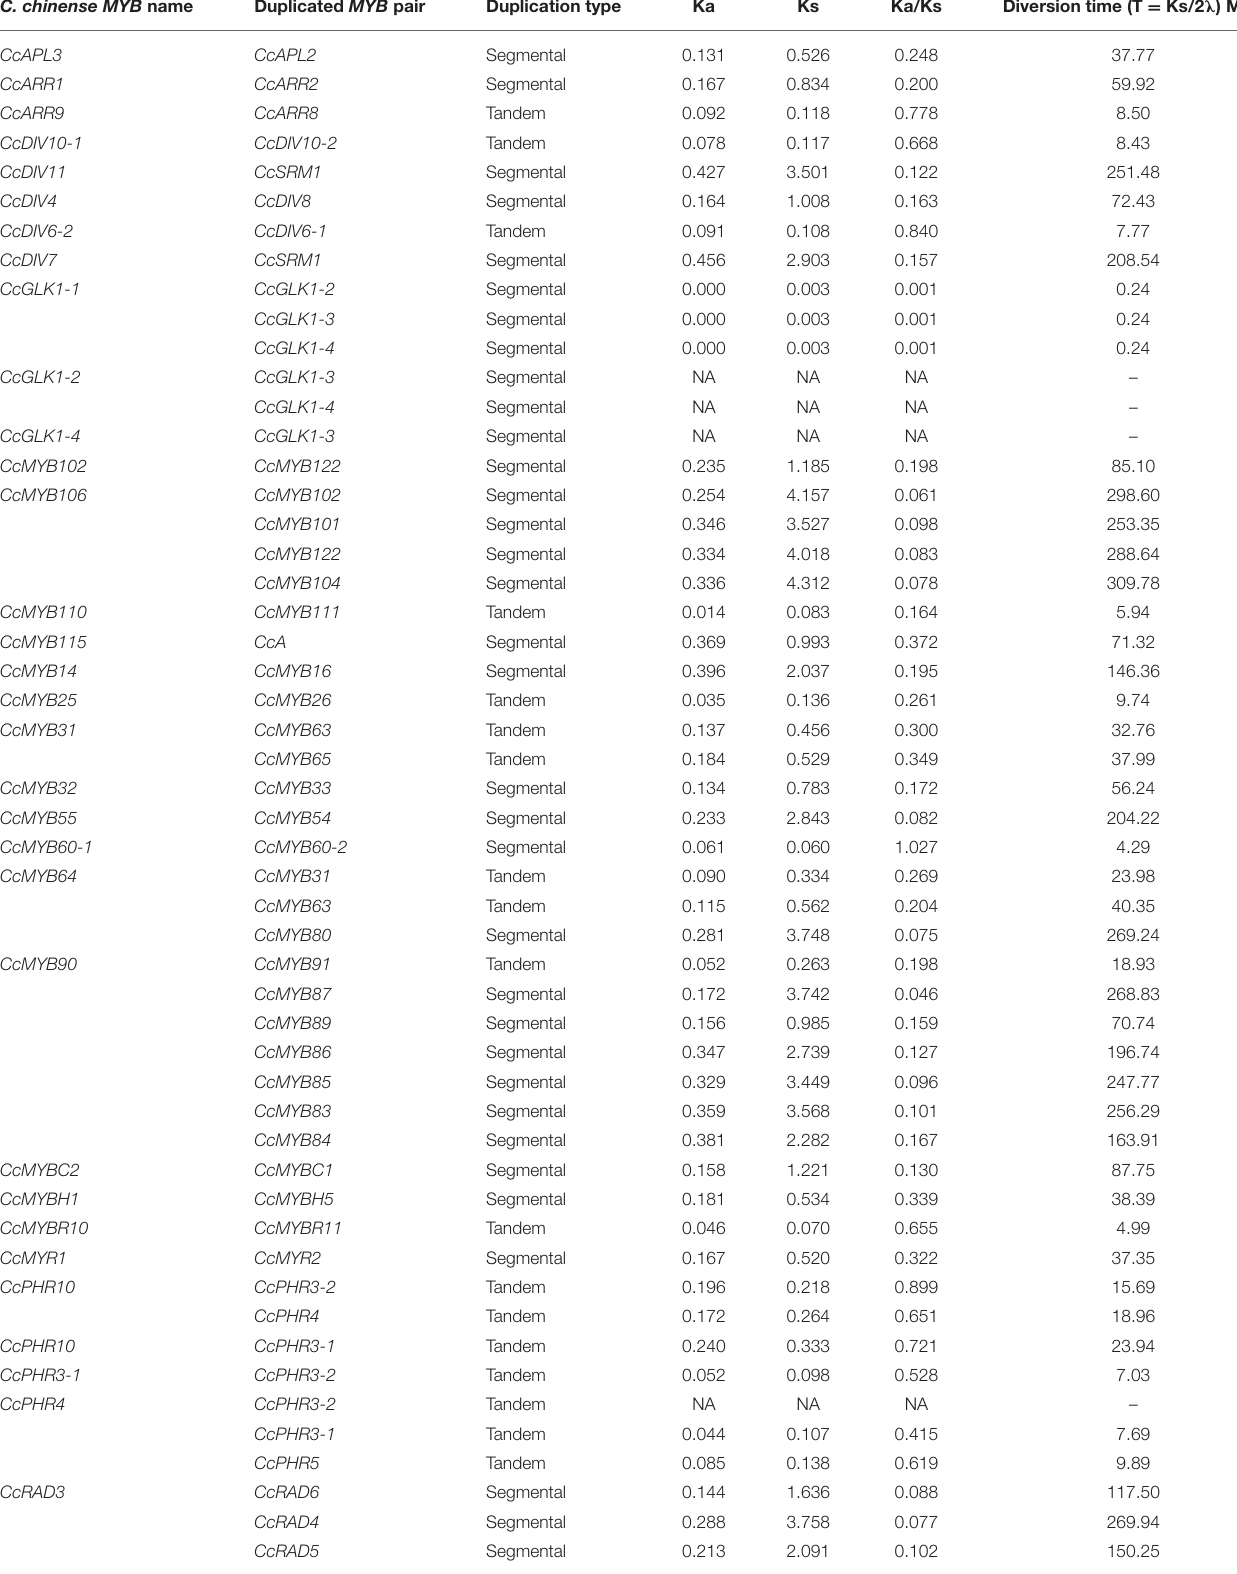
TABLE 1 | MYB gene duplicates in the Capsicum chinense